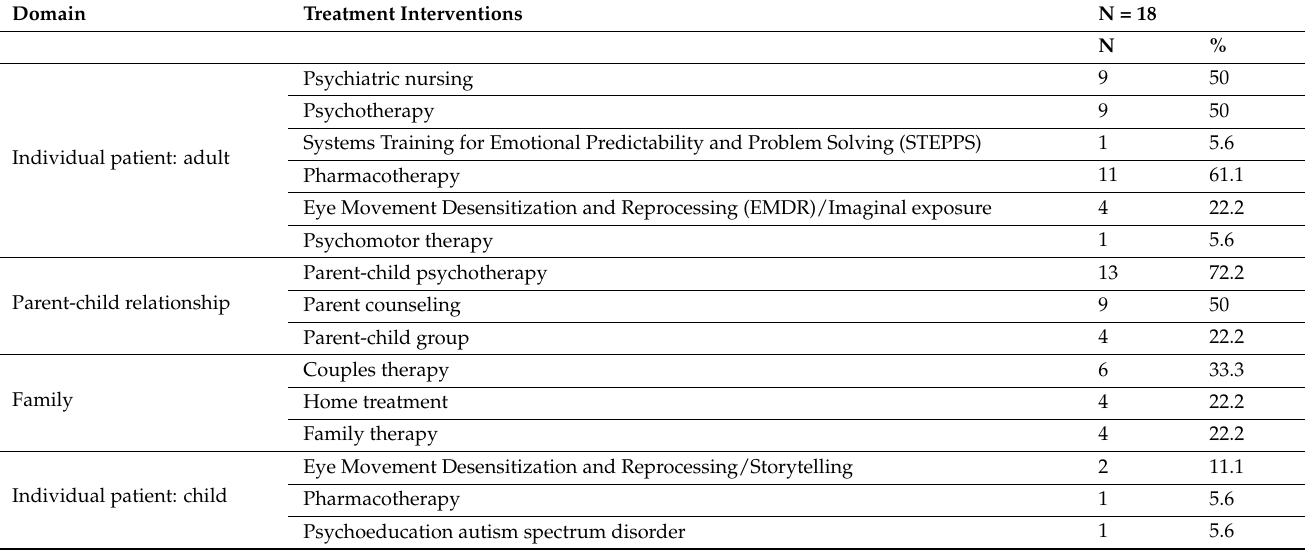
Table 2. Treatment interventions in different